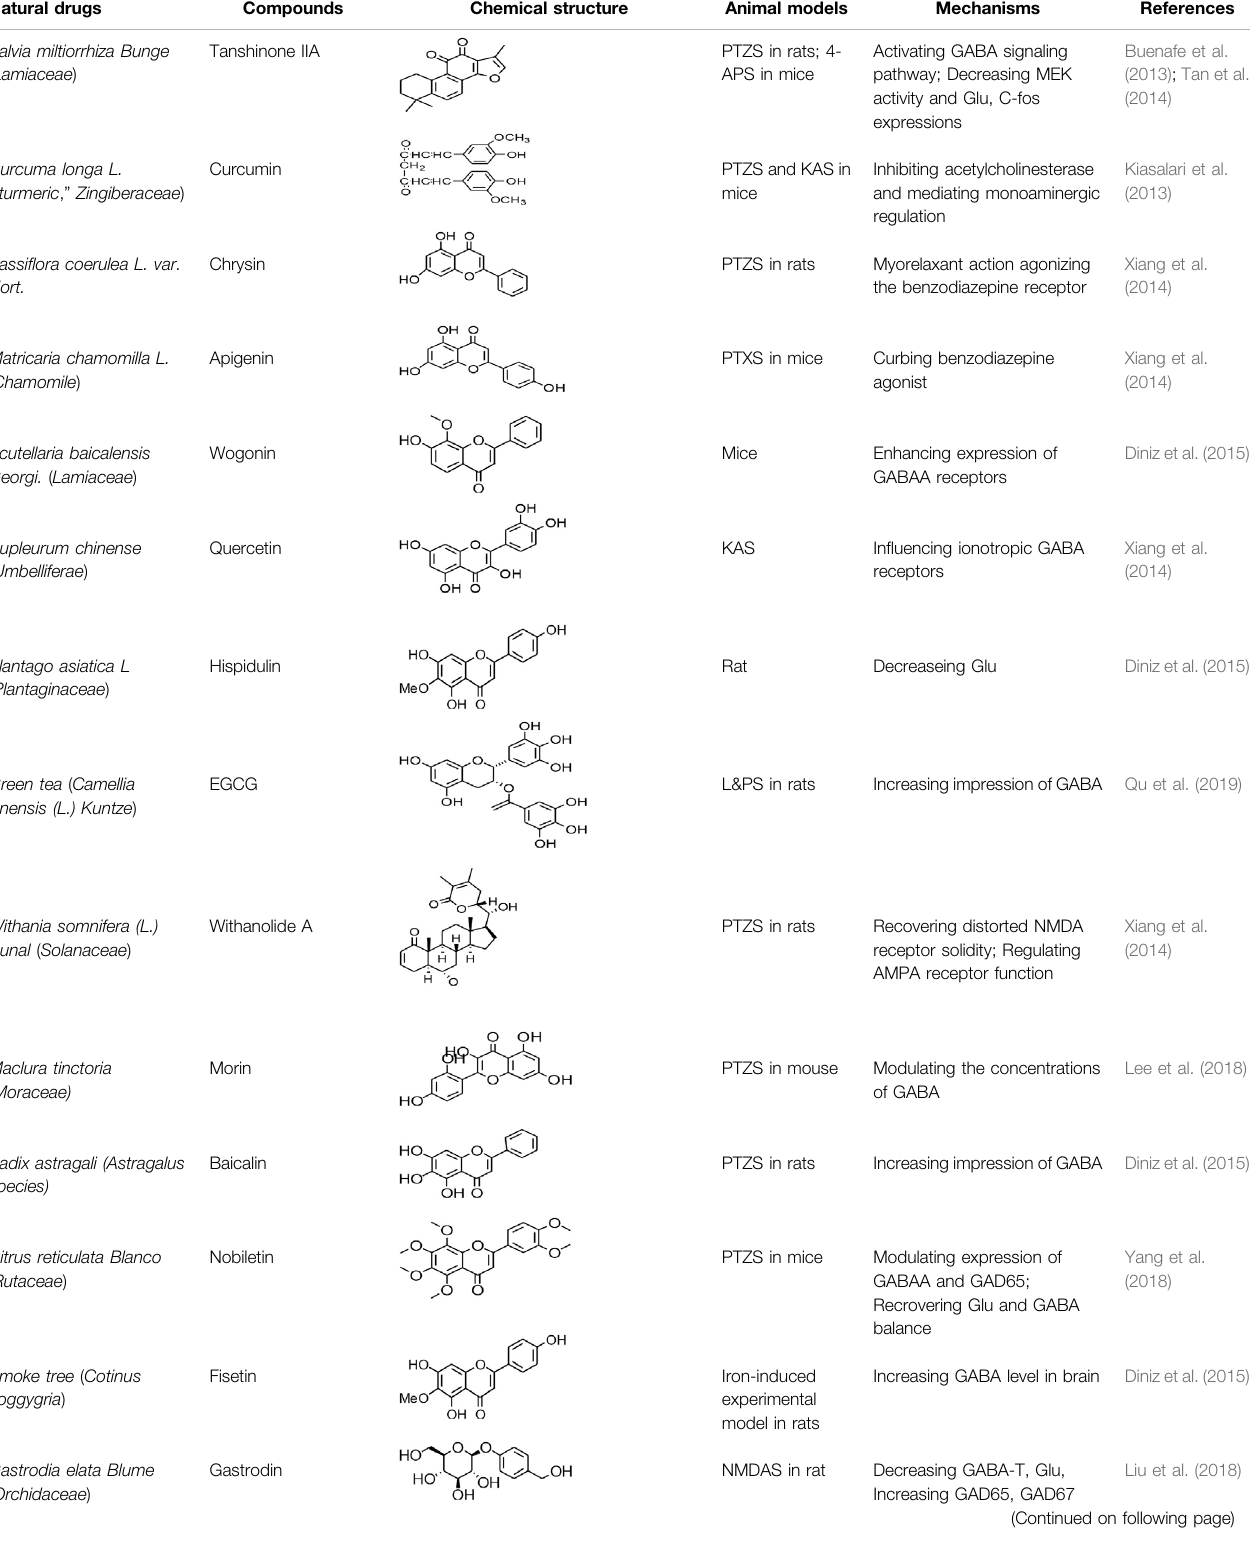
TABLE 2 | Natural drugs used to treat epilepsy by regulating neurotransmitters and synaptic